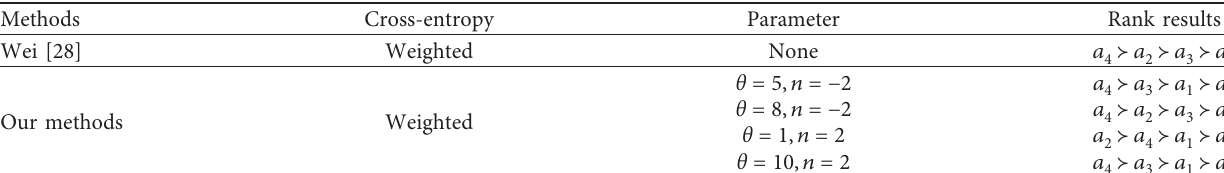
Table 3: Comparative results obtained by different